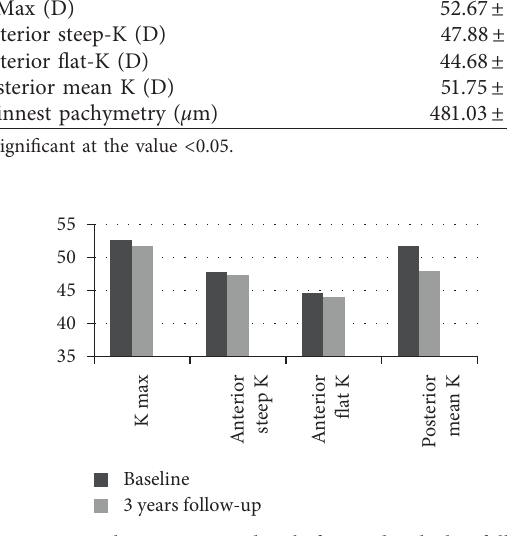
Figure 1: Mean keratometric values before and at the last follow-up after corneal Table 3: Comparison between success and failure subgroups according to baseline characteristics.